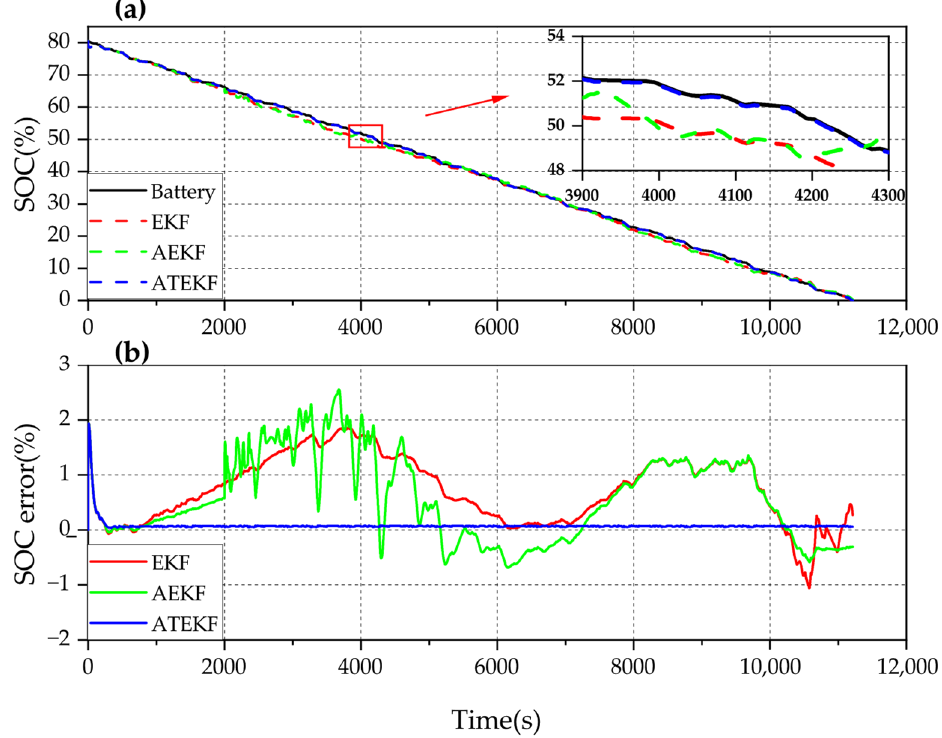
Figure 9. BJDST under 25 °C: ( a ) actual SOC, prediction of EKF, AEKF, and ATEKF; ( b ) SOC error comparison of EKF, AEKF, and ATEKF.